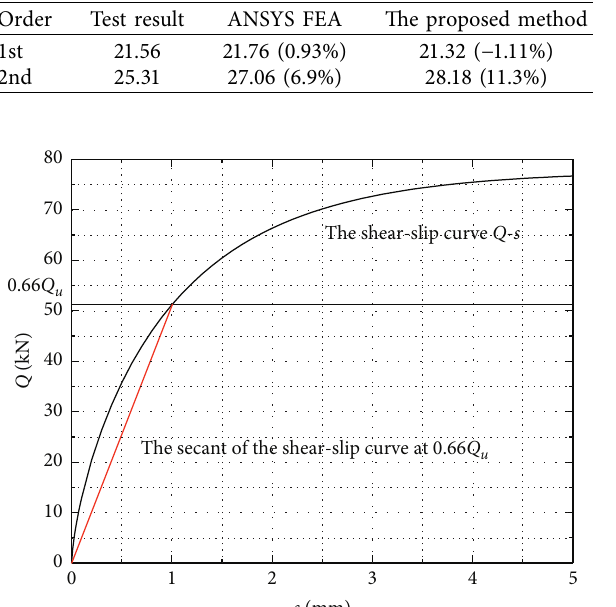
Figure 5: The beam under experimental testing and FEA modeling. (a) The test beam. (b) Test result (21.56Hz). (c) FEA model. (d) FEA